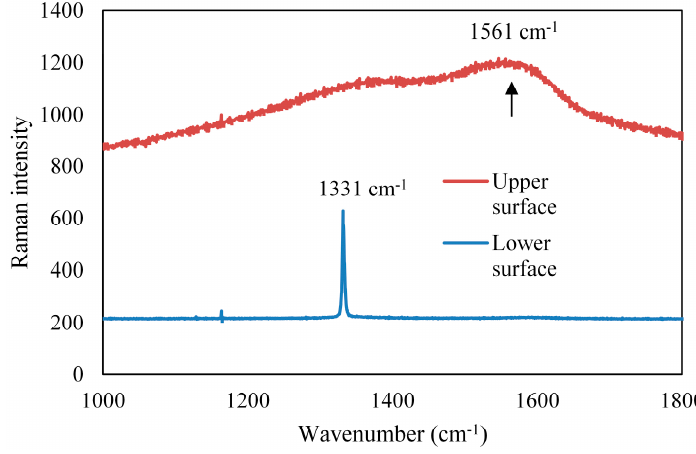
Figure 7. Raman spectra of the point 10 μ m from the edge of the groove.